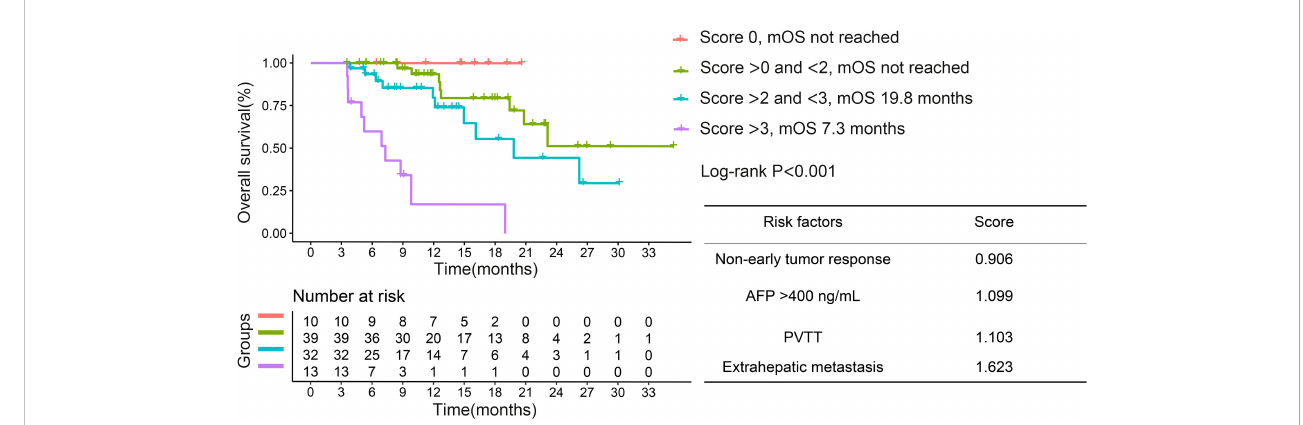
FIGURE 3 Kaplan – Meier curves for overall survival based on different risk factor scores in the entire cohort. PVTT, portal vein tumor thrombosis; AFP, a - fetoprotein; OS, overall survival.